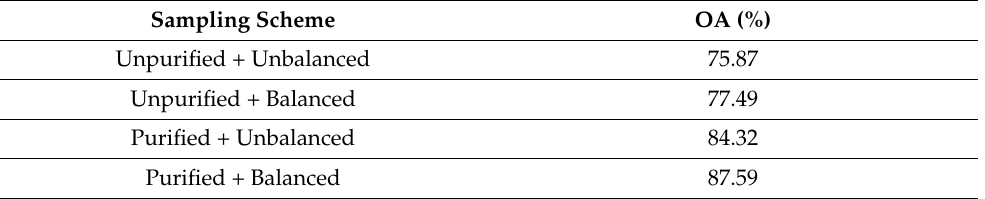
Table 3. Comparison of the accuracies achieved using different schemes in the sampling scheme.